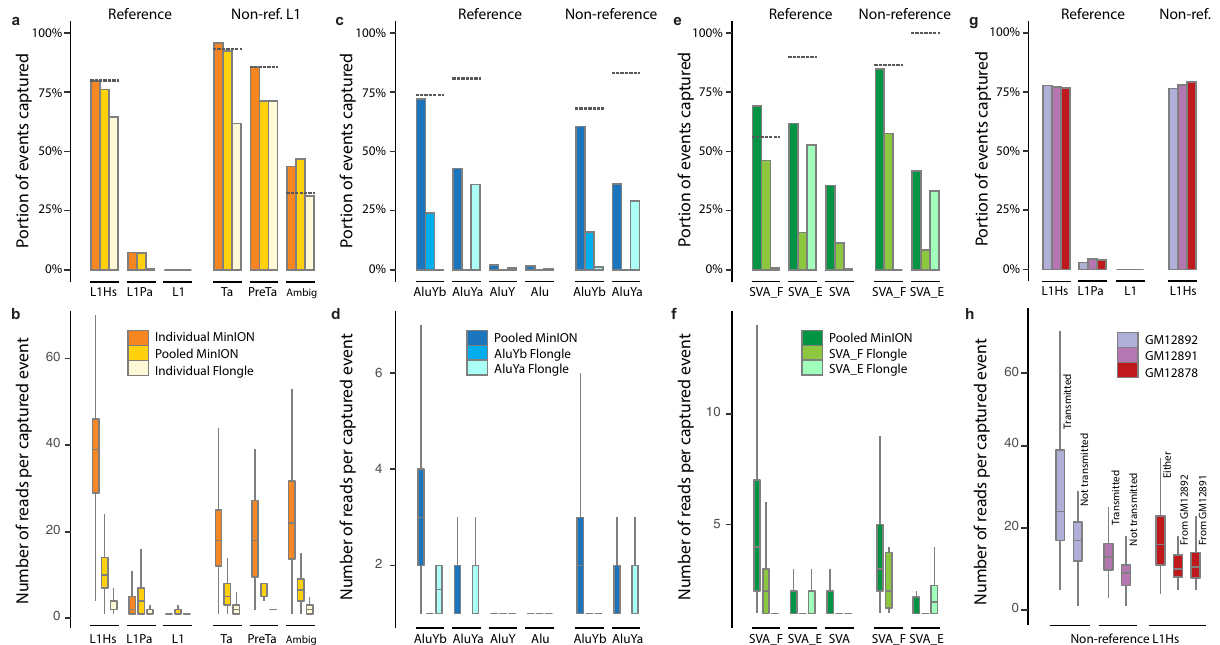
Fig. 3 Systematic evaluation of known MEIs captured by nanopore Cas9 enrichment approach in different fl ow cells. a Known L1Hs in GM12878 recovered by Cas9 targeted enrichment from the individual MinION fl ow cell (FAL11389), pooled-MEI MinION fl ow cell (FAO84736), and individual Flongle fl ow cell (ABB607), displayed as a proportion of the upper-bound known reference L1Hs, L1Pa, and other L1 as well as non-reference (non-ref.) L1Hs from the PacBio-MEI set. Non-reference L1Hs were divided into different subfamilies (L1Ta, L1PreTa, and L1Hs with ambiguous subfamilies). Dotted-gray line represents the intermediate values (as proportion) of MEIs that the guide RNA binds when allowing a ≤ 3 bp mismatch or gap. b Number of supporting reads of each captured L1 in the context of a . c Known Alu Y elements in GM12878 recovered by Cas9 enrichment on one pooled MinION fl ow cell (FAO84736), one individual Alu Yb Flongle fl ow cell (ACK645), and one individual Alu Ya Flongle fl ow cell (ACK655). d The number of supporting reads of each captured Alu element in the context of c . e Known SVA elements in GM12878 recovered by Cas9 enrichment on one pooled MinION fl ow cell (FAO84736), one individual SVA_F Flongle fl ow cell (ACK629), and one individual SVA_E Flongle fl ow cell (ACK395). f The number of supporting reads of each captured SVA element in the context of e . g Known L1Hs captured in the GM12878 trio by Cas9 enrichment on one pooled MinION fl ow cell (FAL15177). h The number of supporting reads of each captured non-reference L1Hs based on transmission in the GM12878 trio. The non-reference L1Hs in the parents (GM12892 and GM12891) were categorized into transmitted and not-transmitted. The non-reference L1Hs in the child (GM12878) were categorized as insertions inherited from GM12892 or GM12891, and from either parents (unknown parental lineage). In b , d , f , h , the numbers of captured MEI subfamily can be found in Supplementary Data 6 with information of mean and standard deviation; The error bars of boxplot range from Q 1 − 1.5 IQR to Q 3 + 1.5 IQR (IQR, interquartile range) and outliers are not shown.